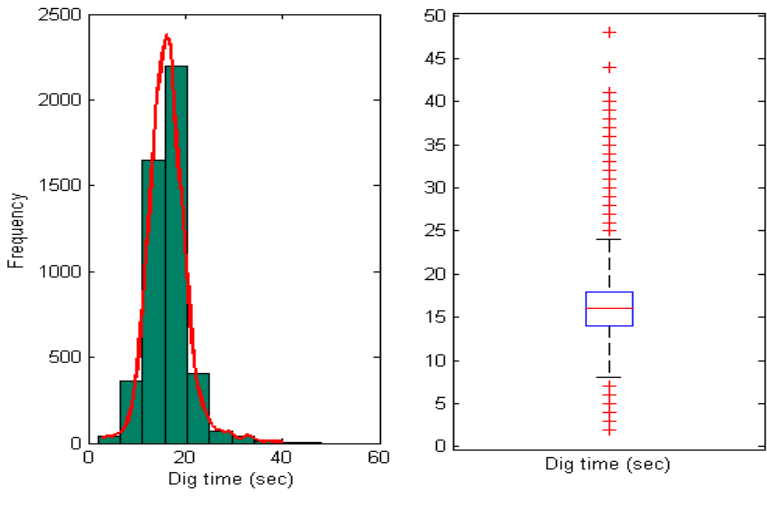
Figure 3. Dig time distribution.